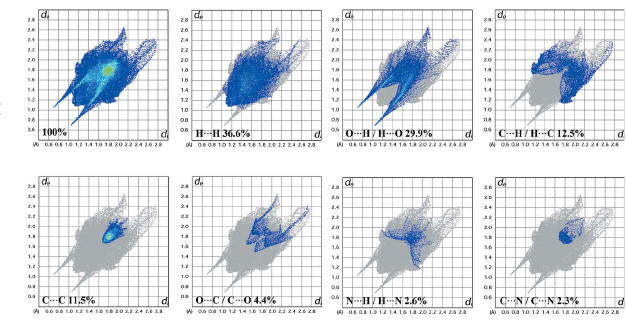
Figure 5 Fingerprint plots of the intermolecular interactions showing the percentage contributions to the total Hirshfeld